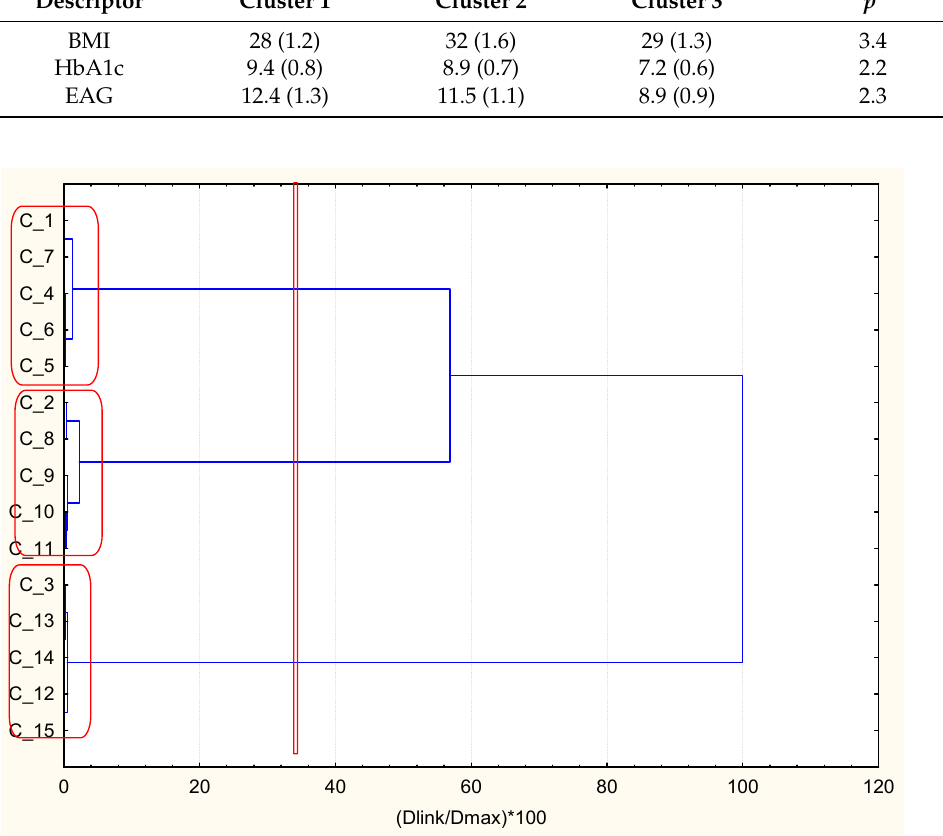
Figure 2. Hierarchical dendrogram for clustering of 15 occasionally selected patients with diabetes mellitus type 2 (DMT2) and arterial hypertonia (AH) as an underlying disease.